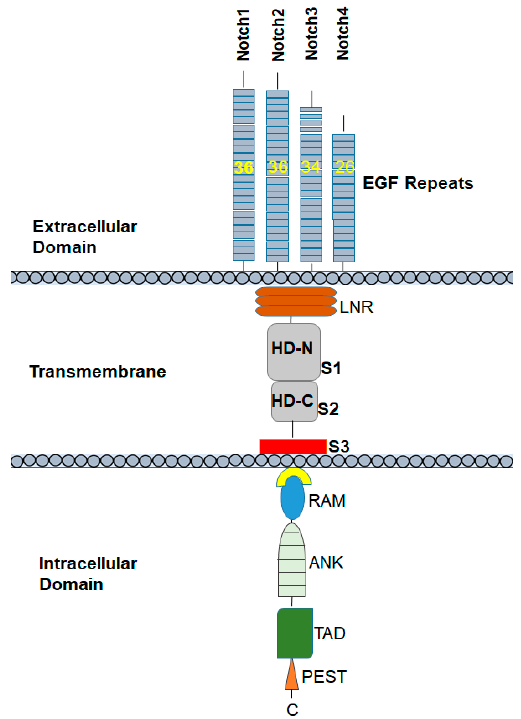
Figure 1. Notch1 receptor structure: the Notch1 receptor has 36 epidermal growth factor (EGF)-like repeats followed by three cleavage sites S1–3, and mutation hotspot regions in the heterodimerization (HD) and proline, glutamine, serine, and threonine residues (PEST) domains.